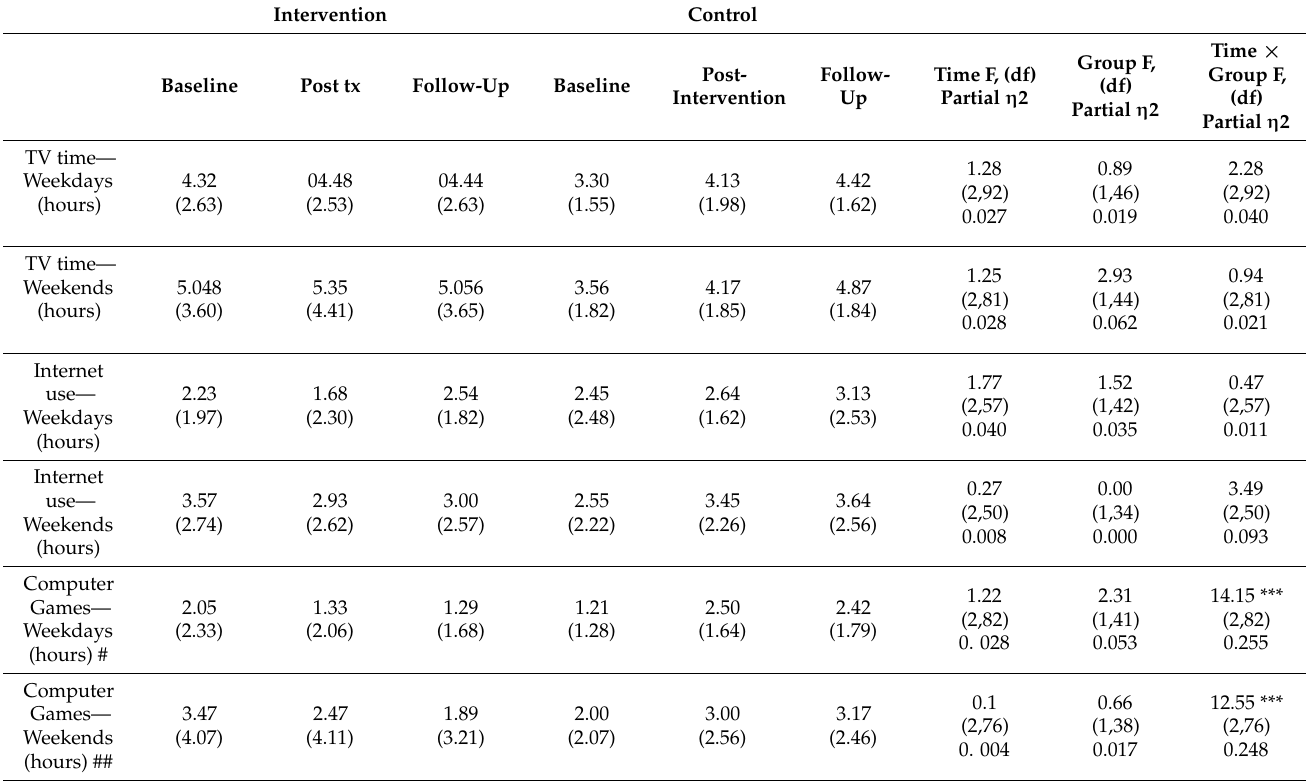
Table 2. Means (SD/df) and partial η 2 of EM measures at baseline, post-intervention and 3 month follow-up, in hours, by time, group, and time*group